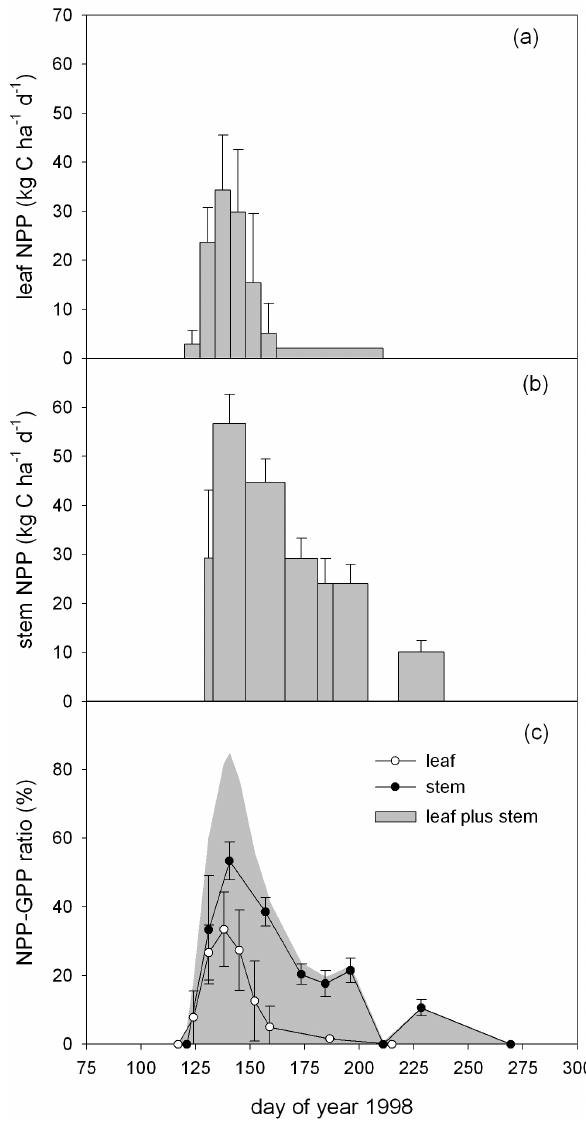
Fig. 5. Seasonal pattern of (a, b) net primary production (NPP) and (c) of the ratio NPP-GPP (GPP: gross primary production), for leaves and stems at the beech stand of Hesse in 1998. Error bars indicate